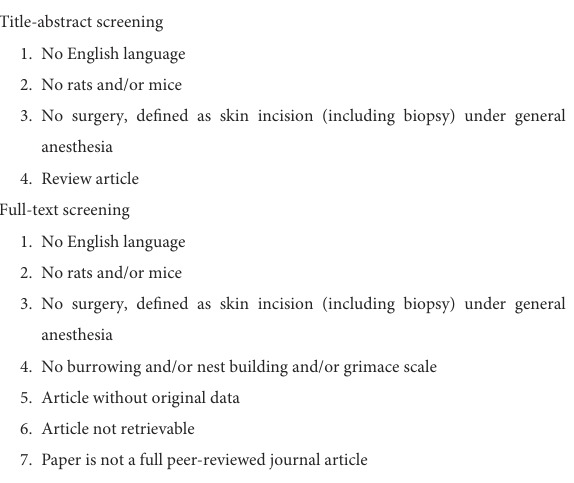
TABLE 1 Exclusion criteria defined in the pre-published